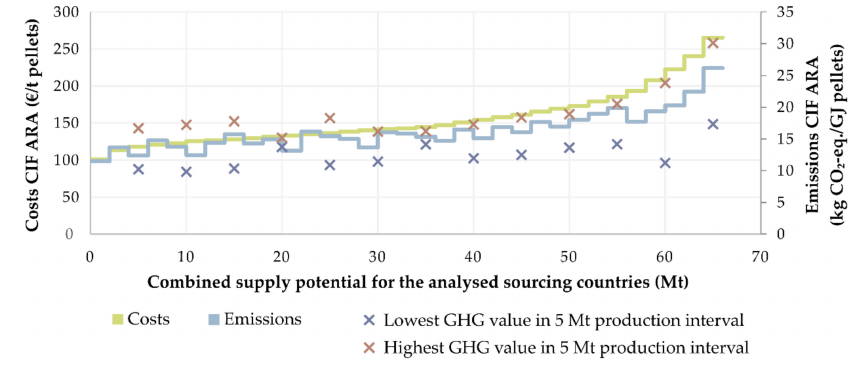
Figure 6. Cost supply curves of wood pellets made from pulpwood with corresponding GHG emissions. Assumed transport on road, across 50 km for feedstock. Shipping transport per Handymax, and SSS ship in the case of transport across the Baltic Sea–Sorted for lowest costs of wood